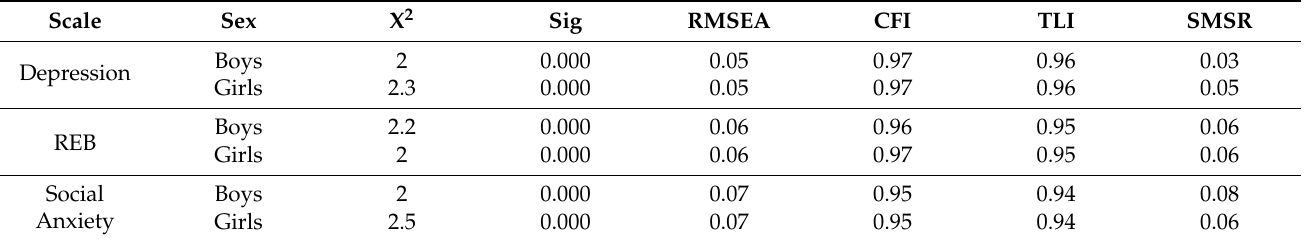
Table 3. Index of goodness of